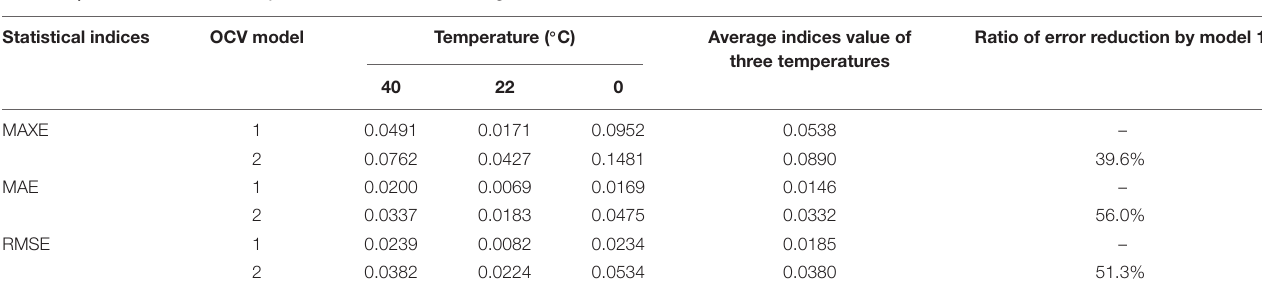
TABLE 6 | Estimate errors and analysis results for the CCD loading